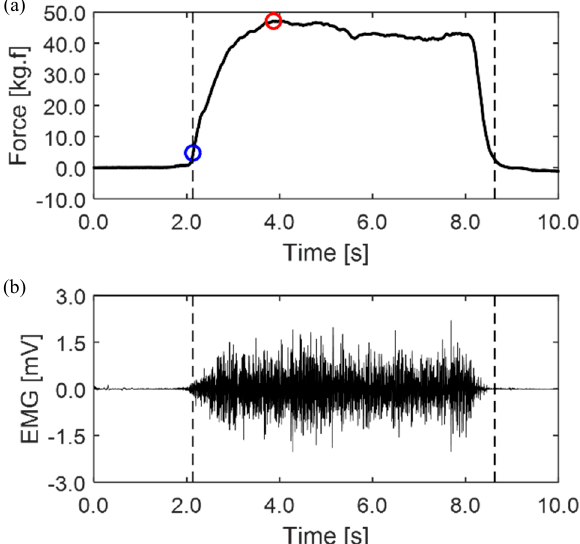
Figure 4. Example signal of muscle fatigue measurement. ( a ) load cell force data, red circle: 100% peak force, blue circle: 10% peak force. ( b ) biceps electromyogram (EMG) data.